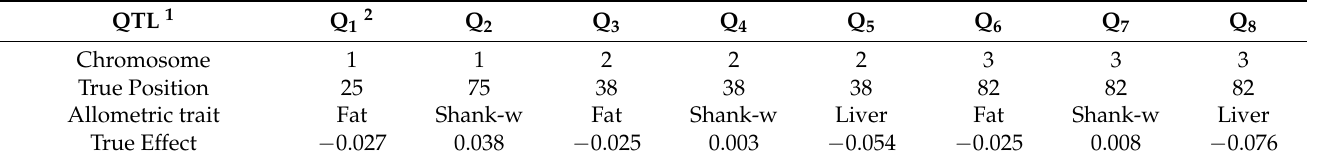
Table 3. Information of the simulated QTLs.